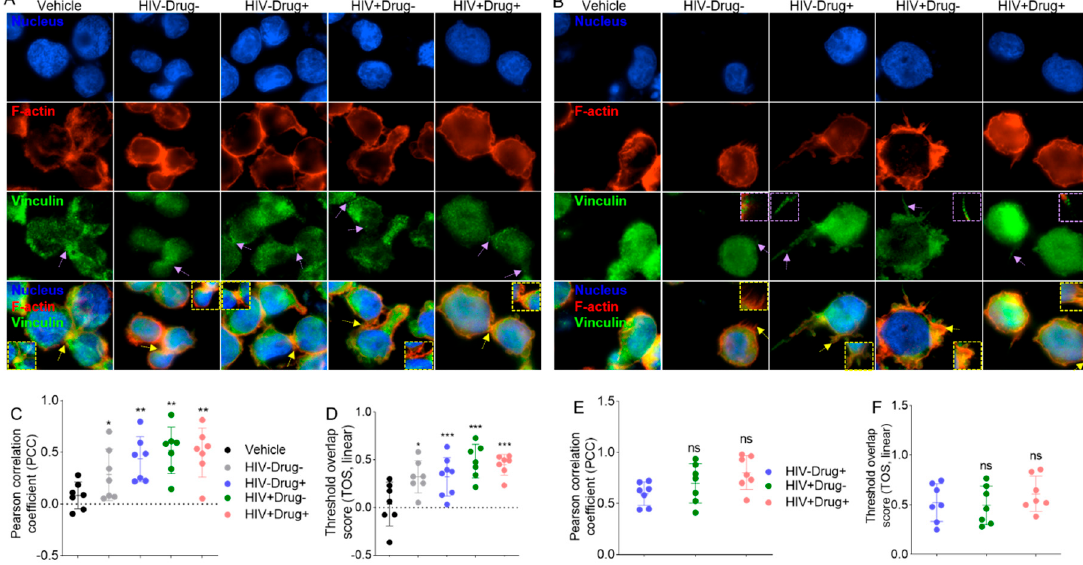
Figure 8. SE induced F-actin • Vinculin colocalization in monocytes. Representative 60 × fluorescence images of U937 cells stained with phalloidin and vinculin to visualize ( A ) F-actin • Vinculin colocalization in adherence junctions. ( B ) F-actin • Vinculin colocalization in cell protrusions. Scale bar = 30 µ m. Pearson correlation coe ffi cient (PPC) and threshold overlap score (TOS, linear) plots corresponding to the images in Figure 8A,B for comparison of F-actin • Vinculin colocalization in adherence junctions ( C , D ) and cell protrusions ( E , F ). Purple arrows indicate vinculin in AJs (Figure 8A) or in areas of cell protrusion (Figure 8B). Yellow arrows indicate F-actin • Vinculin complex in AJs (Figure 8A) and areas of cell protrusions (Figure 8B). Ordinary one-way ANOVA (Dunnett’s correction) was used to assess statistical significance relative to vehicle. * p < 0.05, ** p < 0.01, *** p < 0.005, and ns,